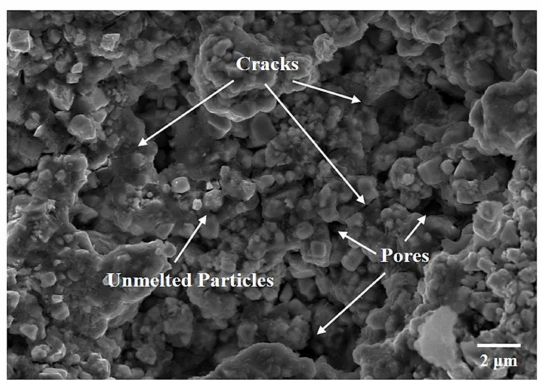
Figure 9. Surface morphology of the HT 1100 coating before cavitation erosion.